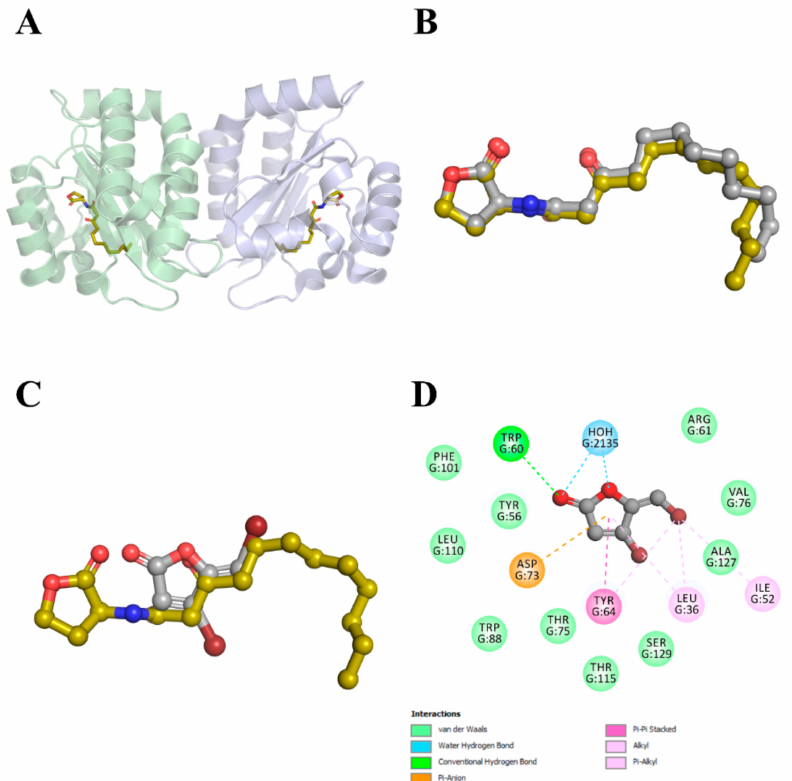
Figure 4. LasR–ligand docking and interaction profiling. ( A ) Ribbon representation of the biological assembly of the P. aeruginosa LasR ligand-binding domain, with two bound 3-oxo-C12-HSL molecules shown as gold sticks (PDB identifier: 2UV0). ( B ) Close-up view of the superposed structures of native (gold) and redocked (silver) 3-oxo-C12-HSL in the autoinducer-binding cavity of LasR (PDB identifier: 2UV0; chain identifier: G). ( C ) Close-up view of the superposed structures of native 3-oxo-C12-HSL (gold) and cross-docked (silver) furanone C-30 in the autoinducer-binding cavity of LasR (PDB identifier: 2UV0; chain identifier: G). ( D ) Favorable non-covalent interactions that are predicted to occur between furanone C-30 and LasR. The images ( A – C ) were rendered using the PyMOL Molecular Graphics System, v1.8 (Schrödinger LLC, Portland, OR, USA). The image ( D ) was rendered using Discovery Studio Visualizer, v16.1.0 (Dassault Syst è mes BIOVIA Corp., San Diego, CA, USA).